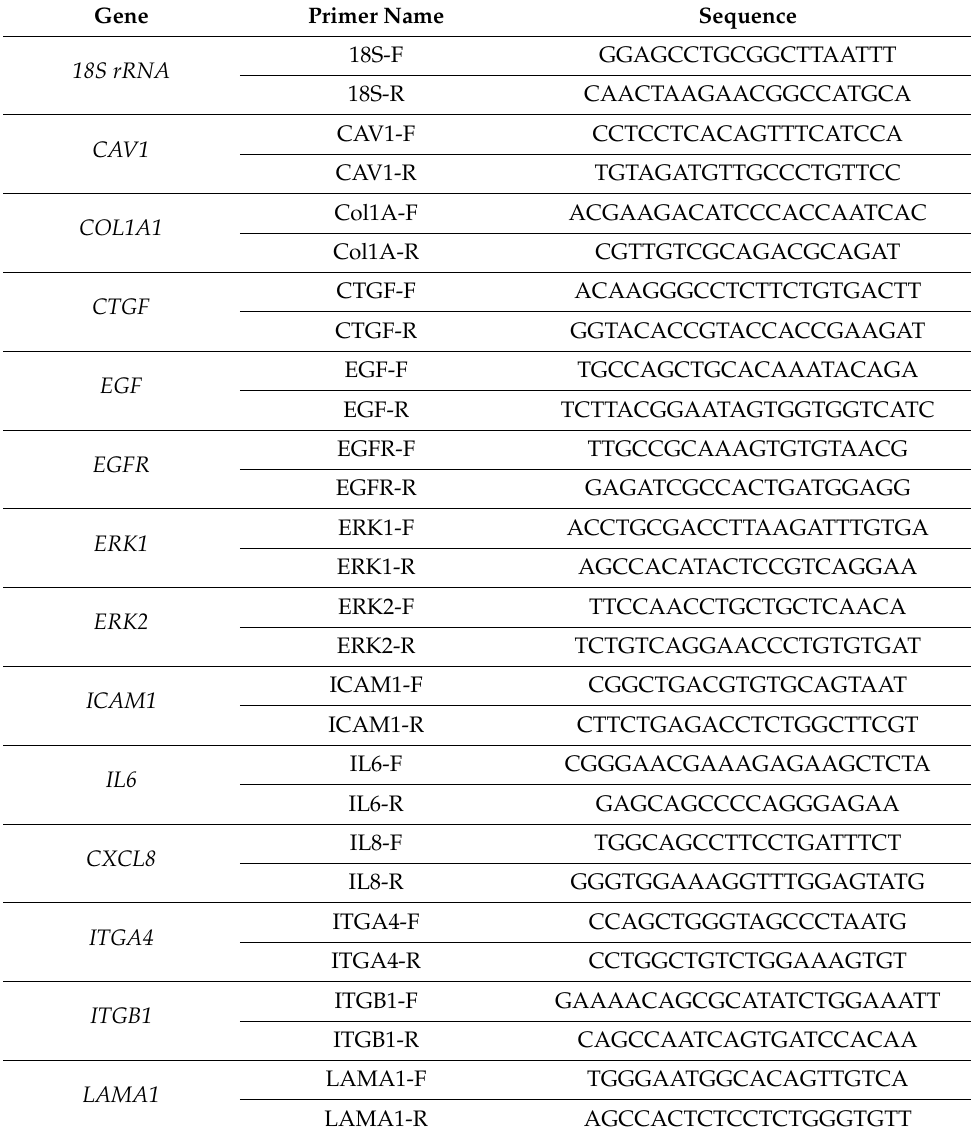
Table 2. Primers used for quantitative real-time polymerase chain